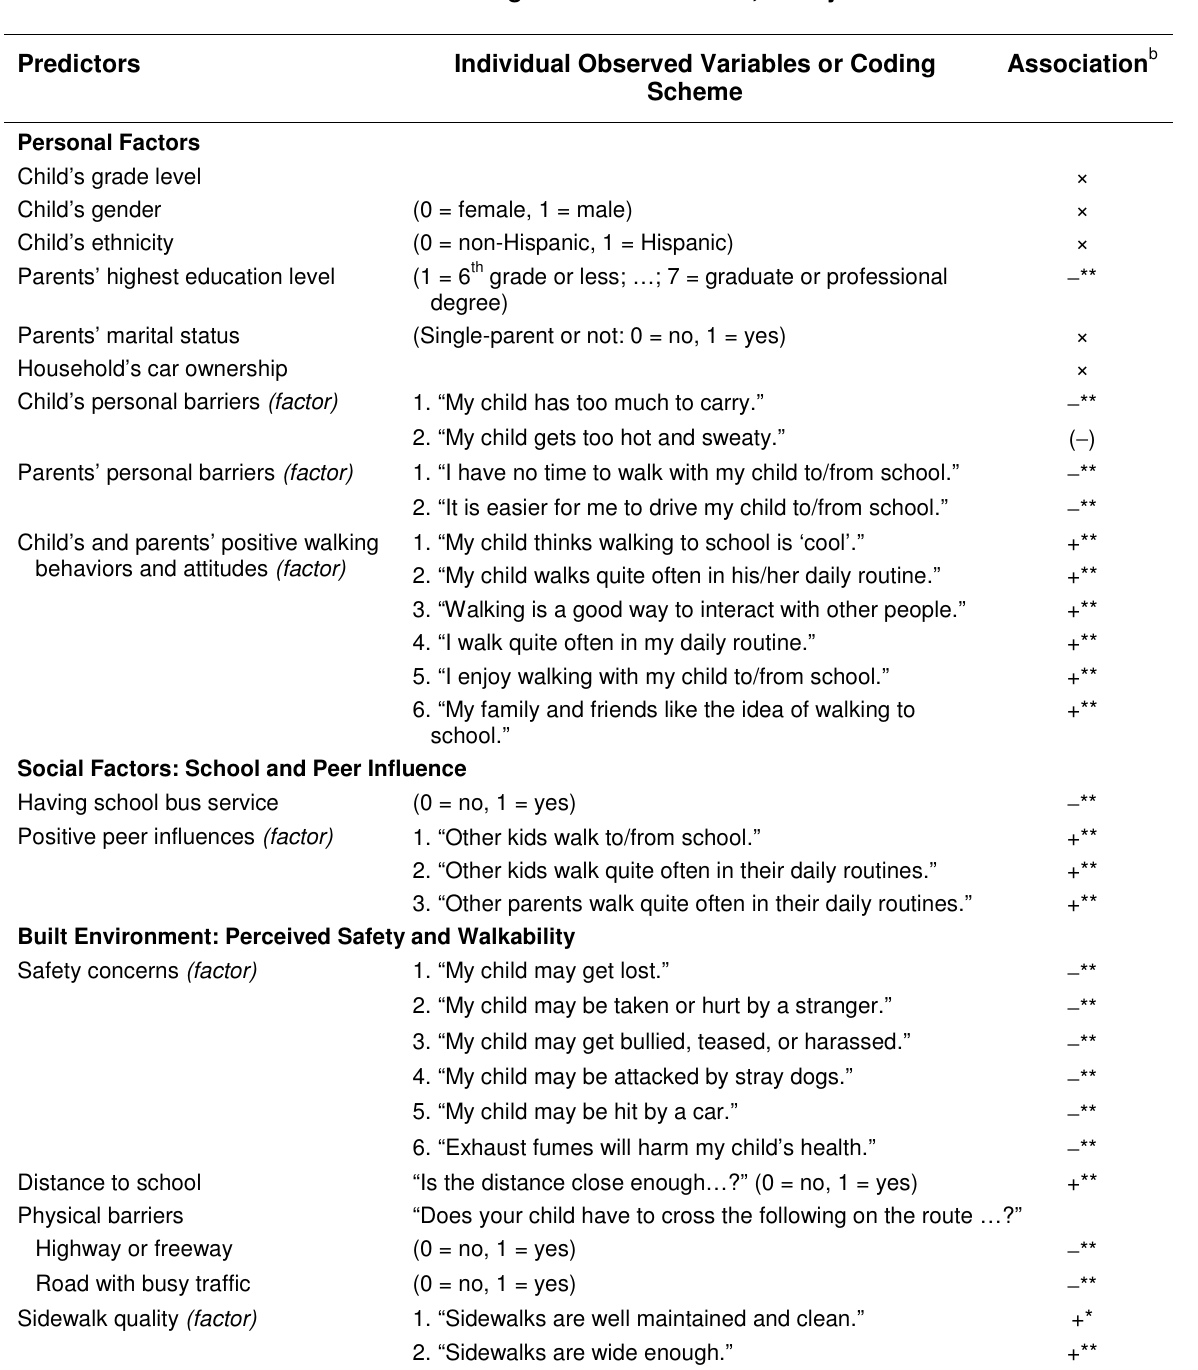
Predictors of Walking To or From School, Unadjusted